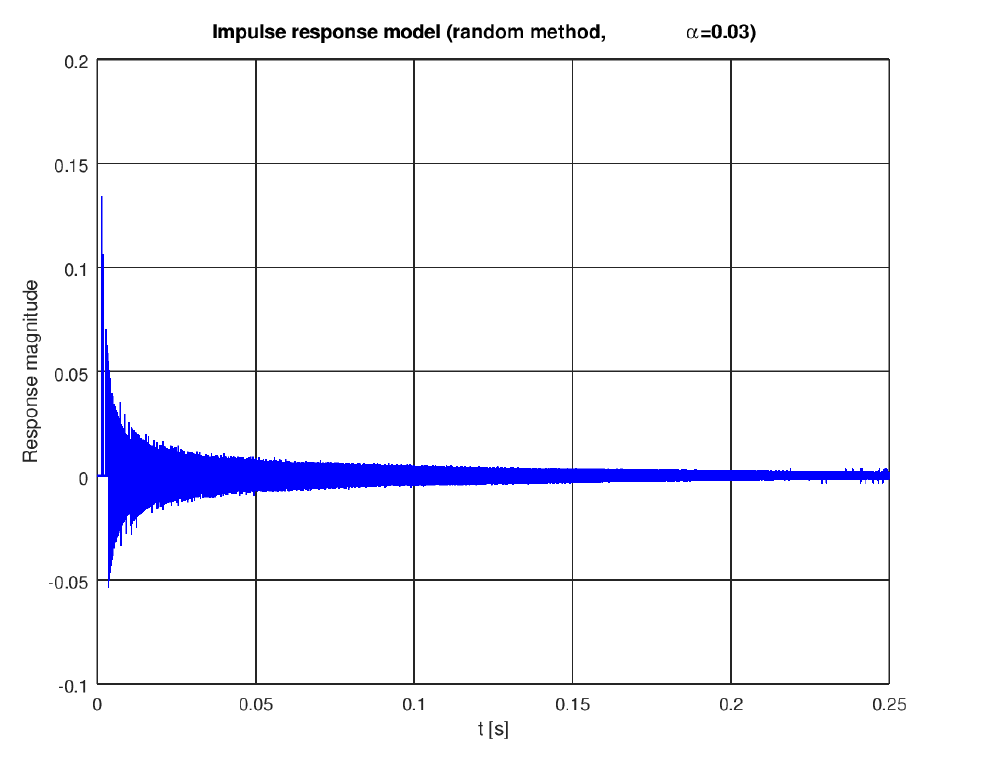
Figure 4. Impulse response of a pool—effect of the random